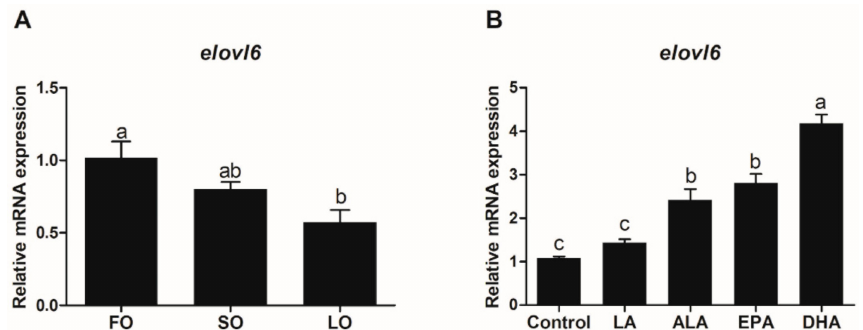
Figure 5. Effects of fatty acids on the transcriptional expression of elovl6 in rainbow trout. ( A ) The elovl6 expression in the liver of rainbow trout that were fed diets containing fish oil (FO), soybean oil (SO), and linseed oil (LO). ( B ) The expression of elvol6 in hepatocytes of rainbow trout treated with 100 µ M linoleic acid (LA), α -linolenic acid (ALA), eicosapentaenoic acid (EPA), and docosahexaenoic acid (DHA) for 12 h. FO and the control group were selected as normalization. Data were presented as means ± S.E.M. (n = 3). Means that share the same superscript letter are not significantly different ( p > 0.05).